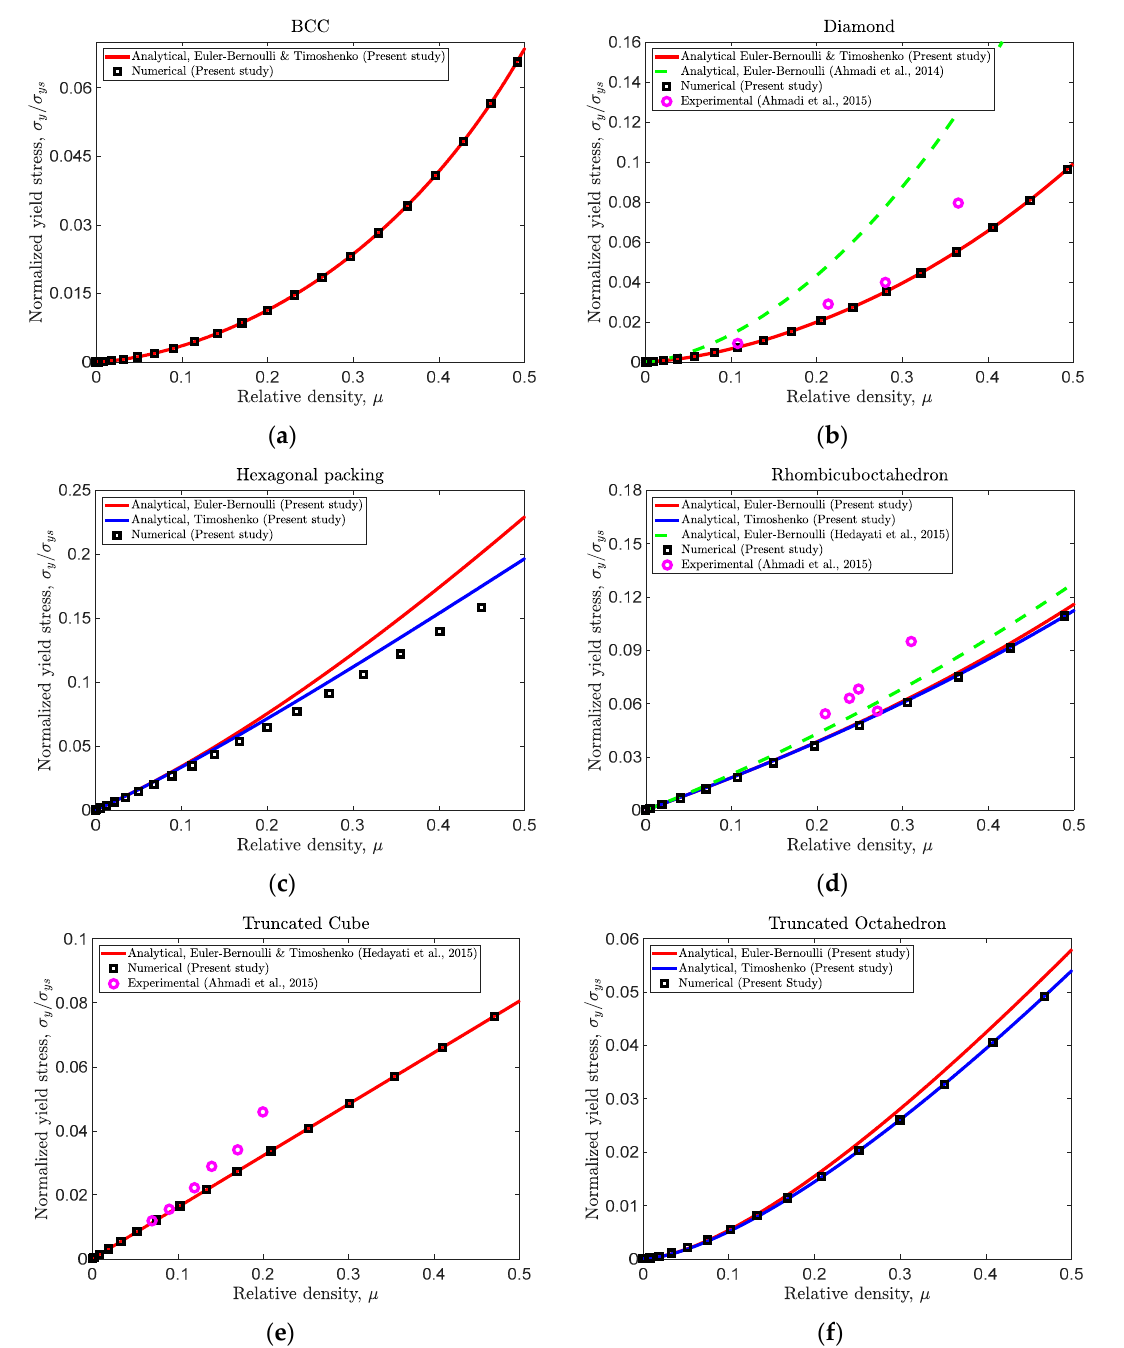
Figure 8. Comparison of analytical (Euler–Bernoulli and Timoshenko) and numerical values of yield stress for different unit cell types: ( a ) BCC, ( b ) diamond, ( c ) hexagonal packing, ( d ) rhombicuboctahedron, ( e ) truncated cube, and ( f ) truncated octahedron.